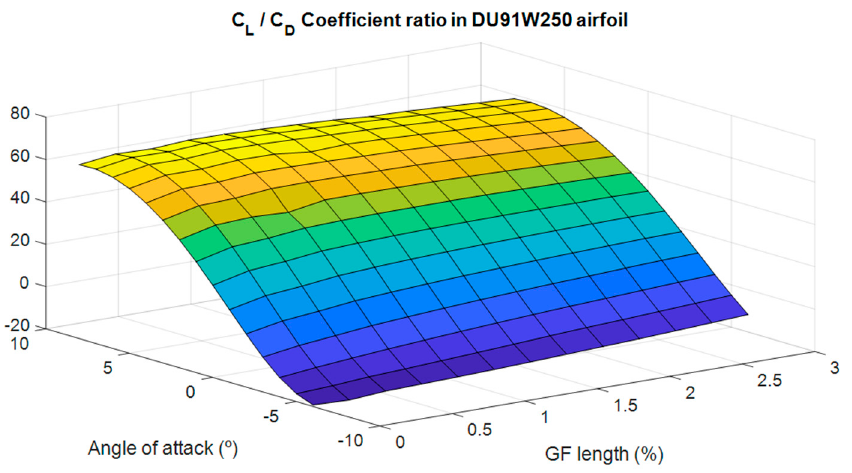
Figure 4. Lift/Drag coefficient ratio vs Angle of attack and GF length in DU91W250